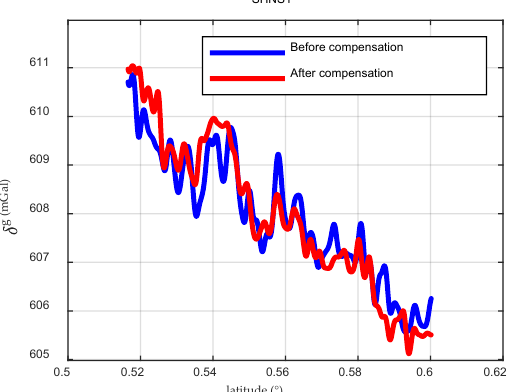
Figure 7. Gravity-measurement results for survey line SHNS1 before and after compensation.